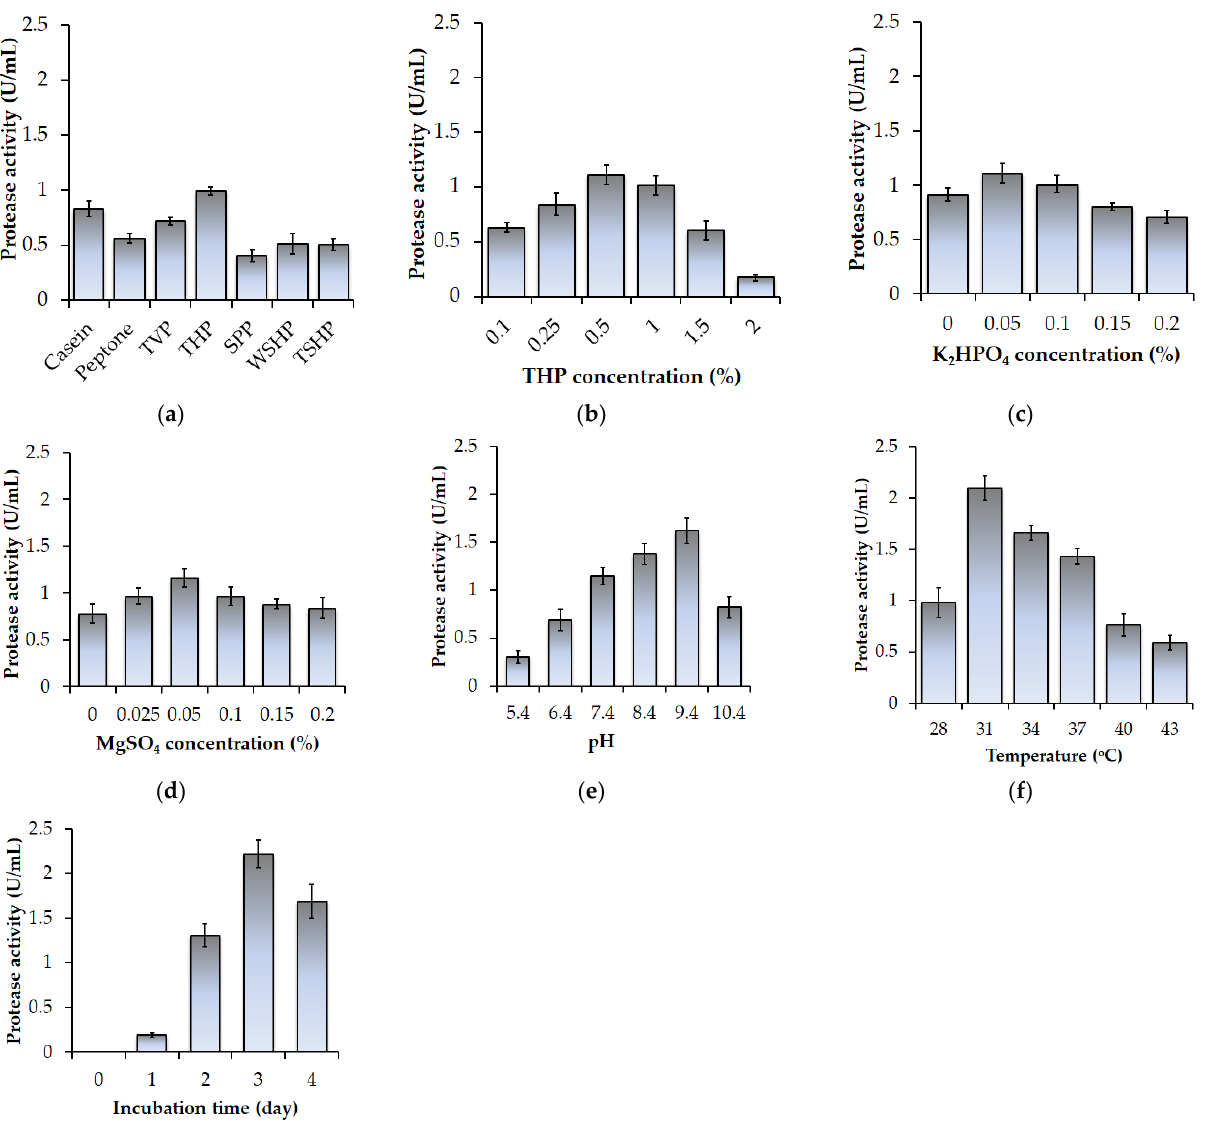
Figure 1. Screening the conditions for protease production using P. elgii TKU051. ( a ) the kinds of C/N source; ( b ) THP concentration; ( c ) K 2 HPO 4 concentration; ( d ) MgSO 4 concentration; ( e ) initial pH; ( f ) incubation temperature; and ( g ) incubation time. The error bars refer to the standard deviation of three replications.